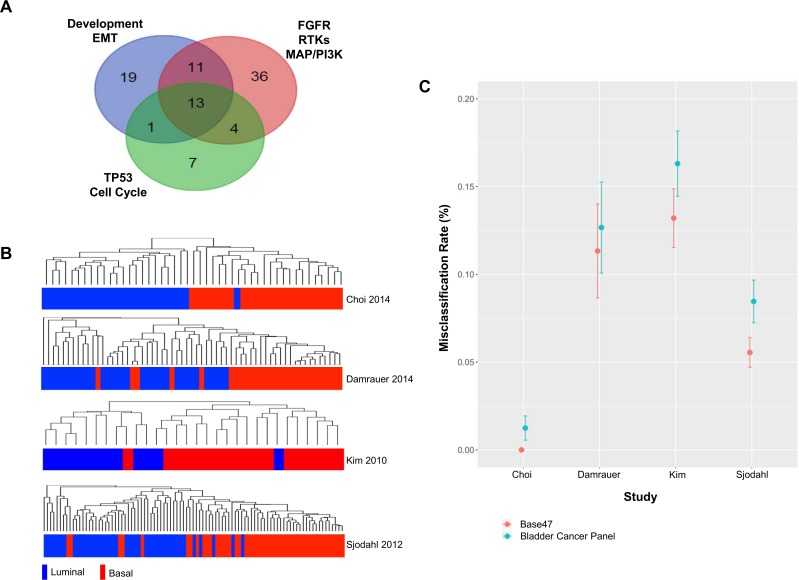
Development and in silico validation of a bladder cancer gene expression panel for characterization of FFPE tissues.(A) Venn diagram of genes comprising a novel bladder cancer panel illustrating the number overlapping (and unique) genes belonging to three main pathway groups based on Ingenuity® analysis: 1) FGFR, RTK, MAPK, and PI3K pathways; 2) development and EMT axes; 3) TP53, genome stability, and cell cycle regulation networks. (B) Hierarchical clustering of samples from four public datasets based on the signals from probes corresponding to genes on the bladder panel, and corresponding published basal/luminal status. (C) Basal/luminal misclassification rates represented as % of all cases in four public datasets comparing calls made by the BASE47 gene signature from literature to assignments made based on the expression of genes on the bladder panel.